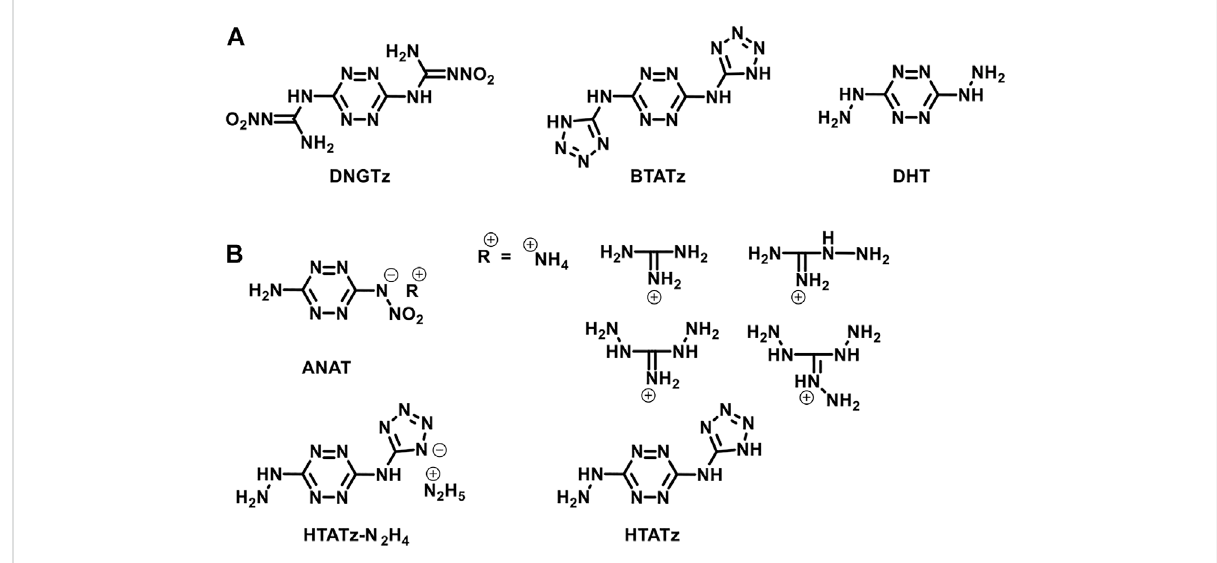
The structures of the representatives of symmetrically and asymmetrically substituted s-teterazine-based energetic materials.